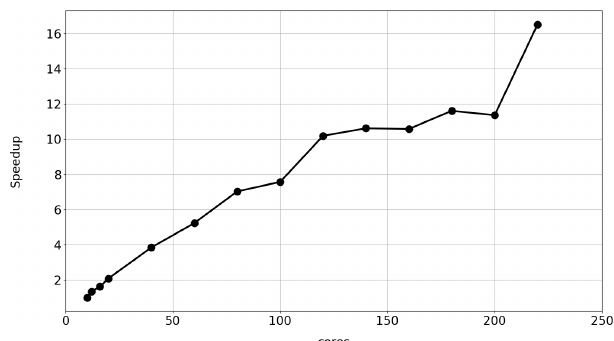
Figure 3. Speedup (execution time of single-core simulation di- vided by execution time of the corresponding multi-core simu- lation) for computing a 10-year distributed COSIPY run on the Zhadang glacier with 206 grid